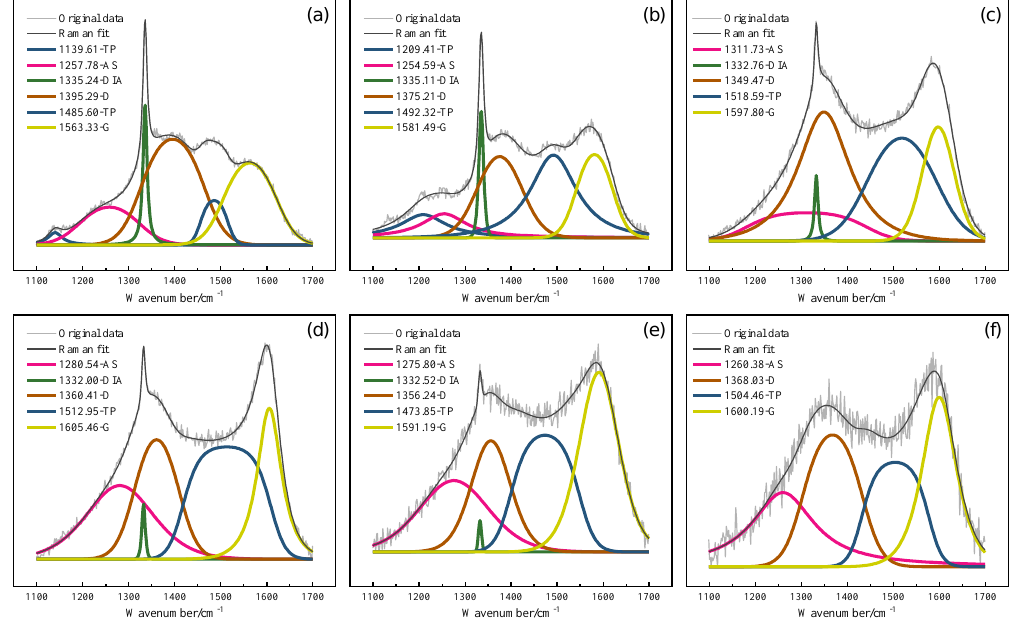
Figure 3. White light (WL) interferometer reconstructed results of fs laser-irradiated regions under di ff erent scanning speeds. ( a ) 2.0 mm / s, ( b ) 1.8 mm / s, ( c ) 1.6 mm / s, ( d ) 1.4 mm / s, ( e ) 1.2 mm / s, and ( f ) the surface roughness Ra and removal rate per laser pulse of diamond coating vs. scanning speed.